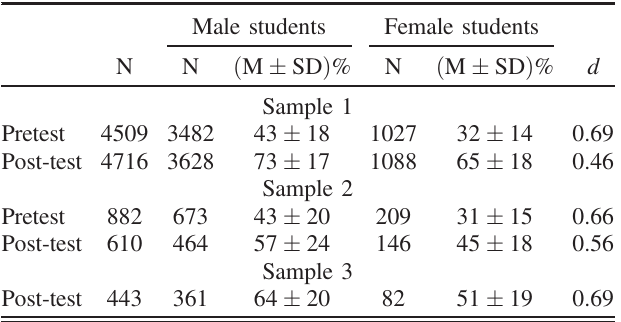
TABLE II. Pretest and post-test averages for all samples. Mean ( M ) and standard deviation (SD) are reported as percentages. No pretest was given in the Sample 3 classes. Cohen ’ s d measures the effect size of the difference between male and female